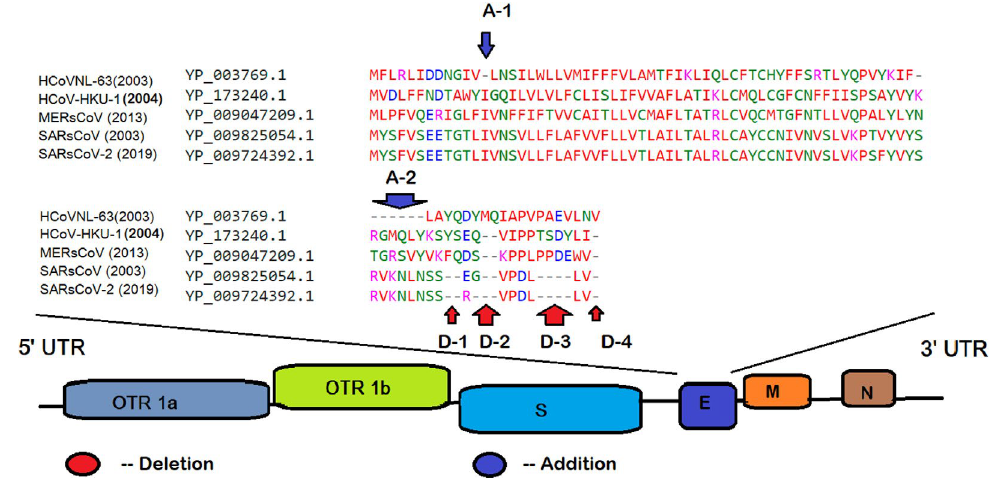
Fig. 1. Multiple Sequence Analysis of Amino Acid Sequence of Envelope Proteins’ of Human